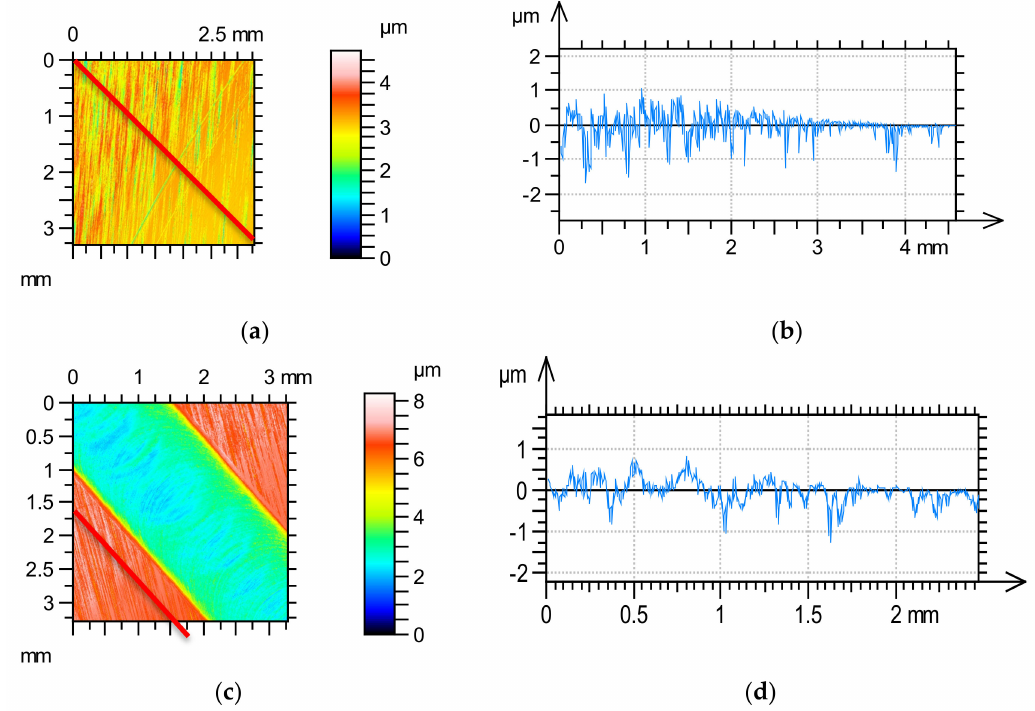
Figure 13. Contour plots ( a,c ) and extracted profiles ( b,d ) of worn untextured disc surface ( a,b ) and surface of type 1 with both side dam bottom shape of the groove ( c,d